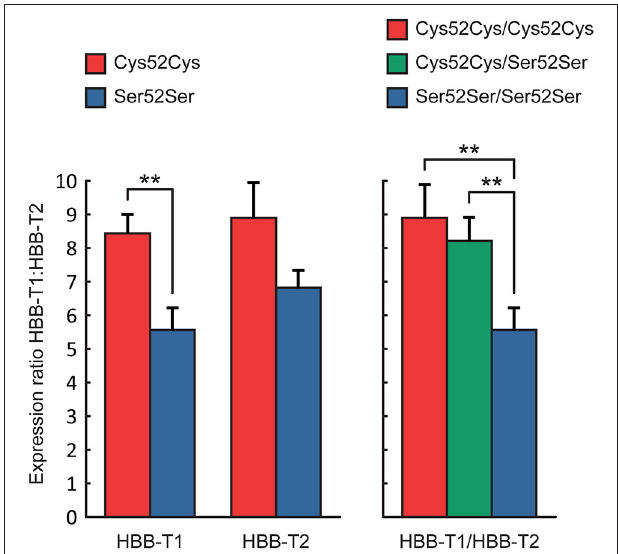
FIGURE 2 | Expression ratio HBB-T1:HBB-T2 (LS Mean ± SE) across single-locus (HBB-T1 and HBB-T2) and two-locus genotypes (HBB-T1/HBB-T2). ** P < 0.01 (ANOVA with Tukey-Kramer test).